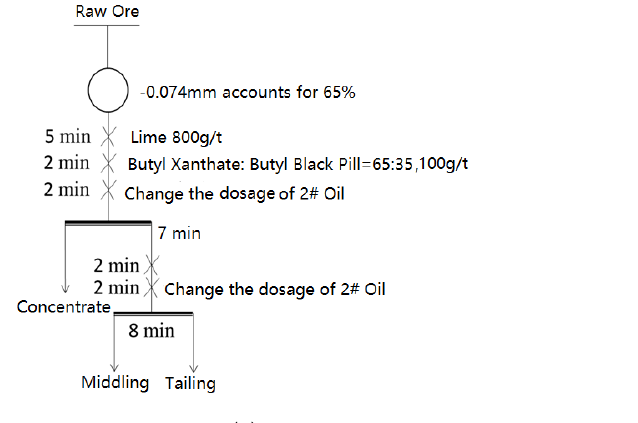
Figure 10. Effect of 2# oil dosage on the recovery of sulfide aggregates. ( a ) The flow chart for flotation experiments ( b ) Effect of 2# oil dosage on the flotation recovery.